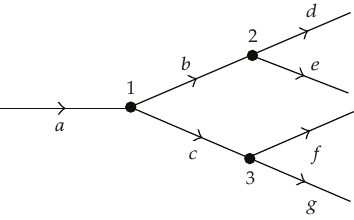
Figure 5: Topology of the symmetric